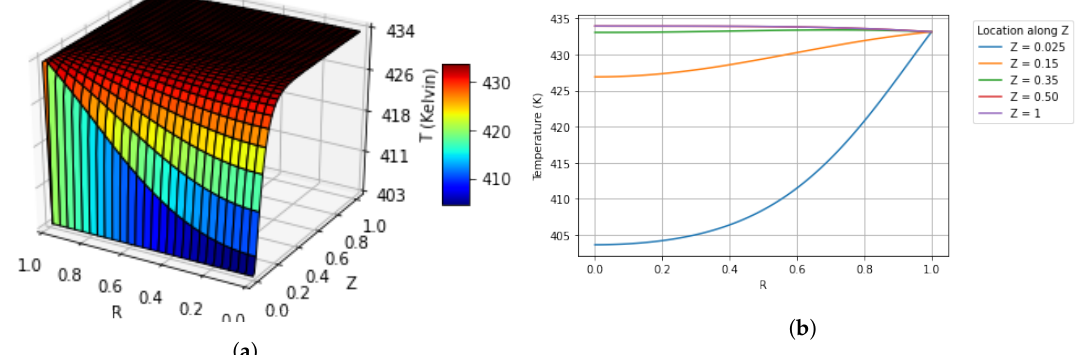
Figure 4. Finite element solutions of temperature distribution of fluid flow inside the circular tube. ( a ) 3D view of temperature distribution in circular tube; ( b ) temperature profile along